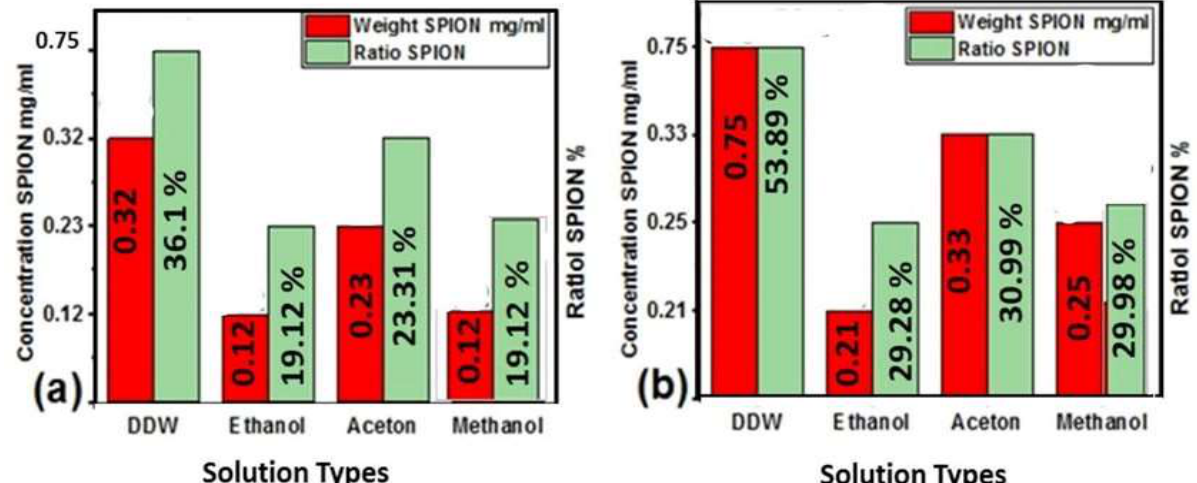
Figure 8: The relationship between SPIONs concentration (red bar), ratio (green bar), and laser fluence/ pulse at a- 10 J /cm 2 and b- 28 J/cm 2 after ablation Fe in different liquid types with wavelength 266